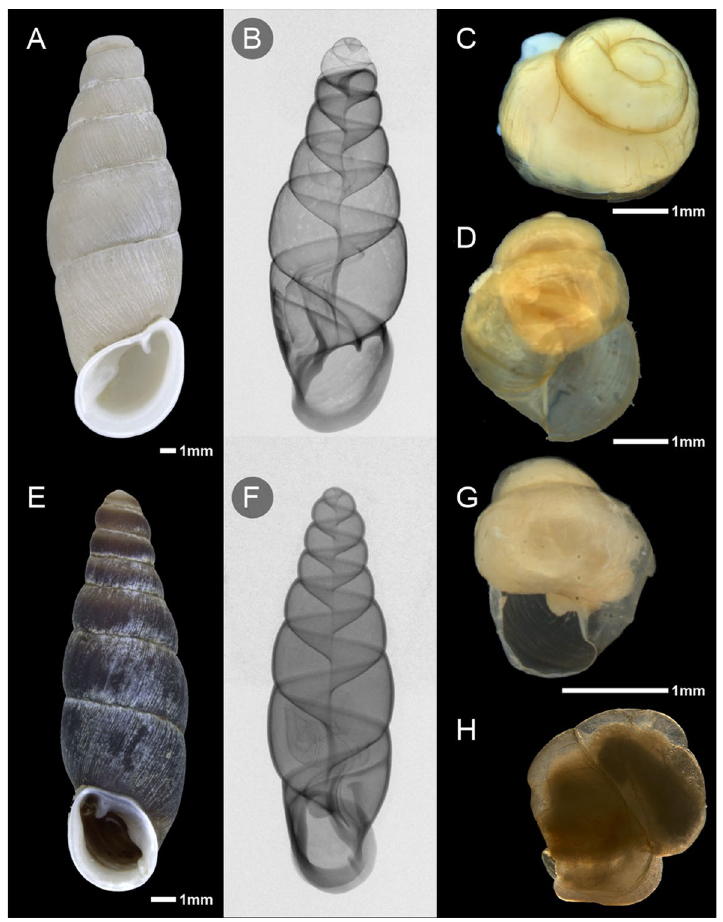
Figure 4. Viviparous clausiliids and their ‘soft-shelled’ neonates born in laboratory culture. ( A–D ) O. miranda : adult shell, X-rayed shell with embryo visible inside, neonates; ( E–H ) Z. ventriosa : adult shell, X-rayed shell with eggs visible inside,